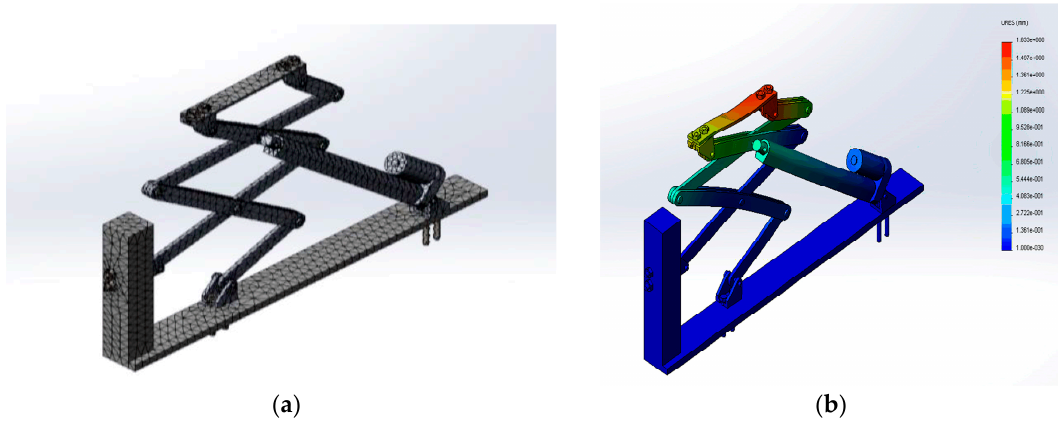
Figure 9. ( a ) Volumetric mesh for the deformation simulation under two force constraints: two actuators of 668 N each and a force 500 N; ( b ) Displacements results where red and blue colors represent a displacement of 1.6 mm and 0 mm, respectively.